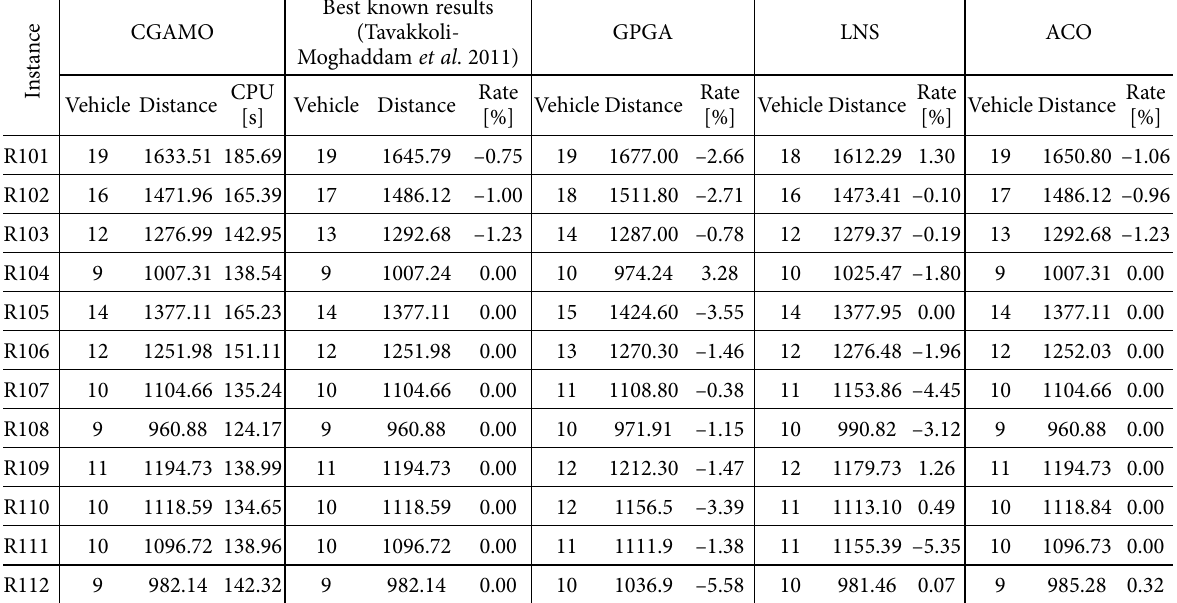
Table 2. Comparison results of different methods for VRPTW of R1